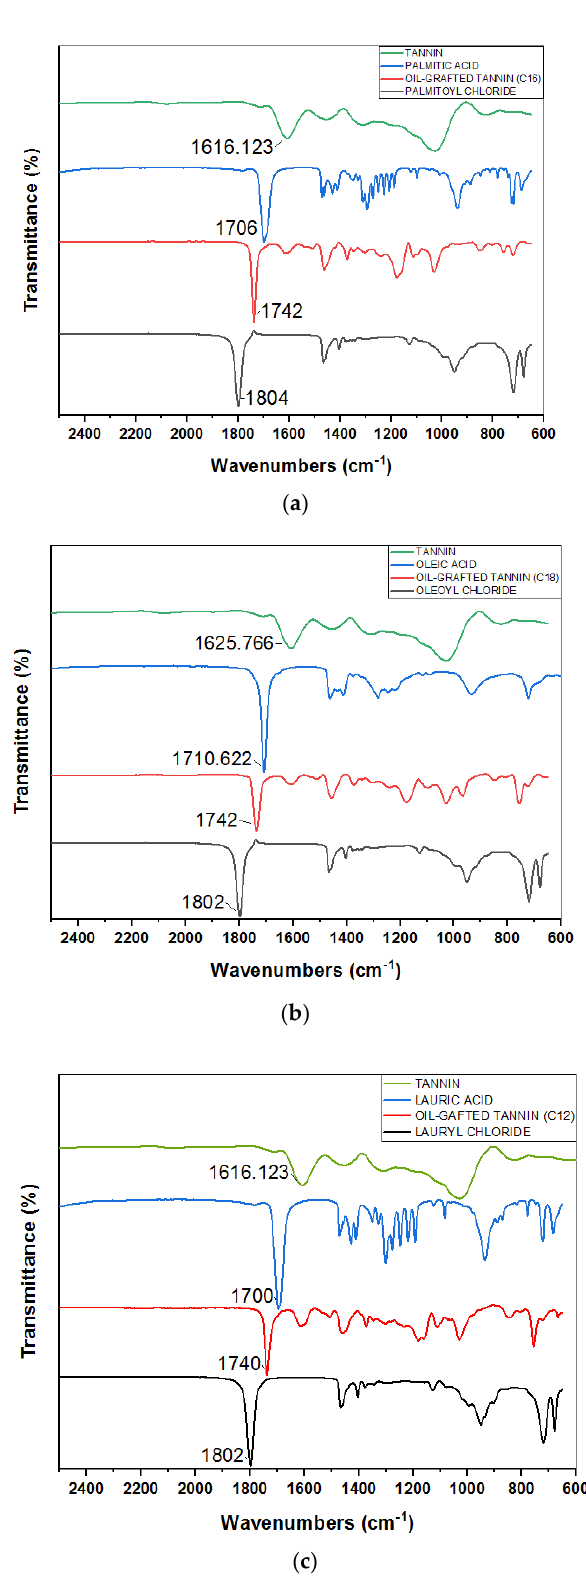
Figure 1. ( a ). FTIR spectra of mimosa tannin, palmitic acid, oil-grafted tannin using palmitoyl chloride, and palmitoyl chloride. ( b ). Comparison of FTIR spectra of mimosa tannin, oleic acid, oil-grafted tannin using oleoyl chloride, and oleoyl chloride. ( c ). Comparison of FTIR spectra of mimosa tannin, lauric acid, oil-grafted tannin using lauryl chloride, and lauryl chloride. Table 2. Yield of oil-grafted tannins using different fatty acid chlorides.